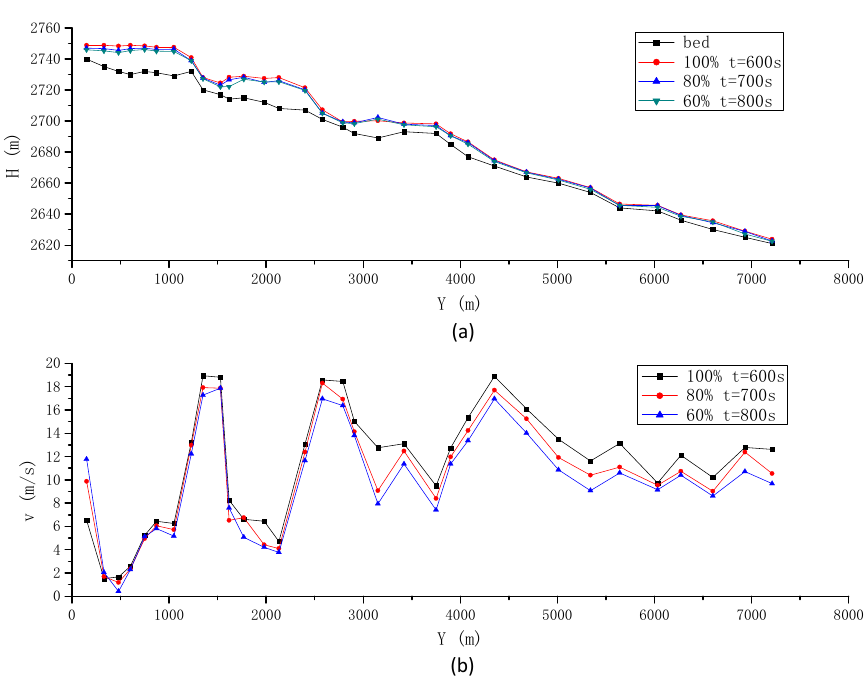
Figure 18. Spatial variations of ( a ) water surface; and ( b ) velocity profile along the central streamwise direction of dam break flow, for different breach conditions.